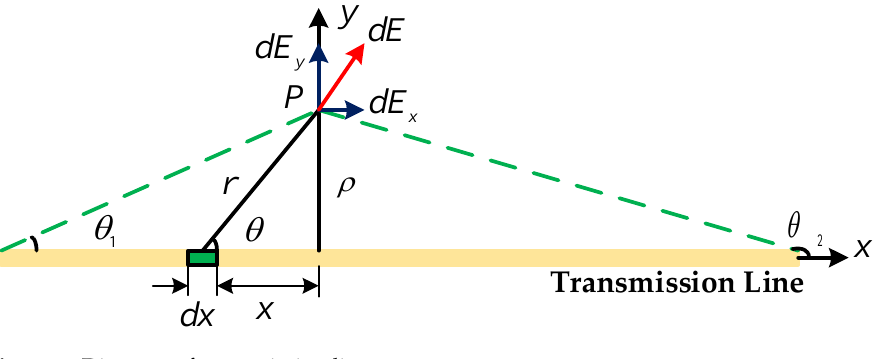
Figure 2. Diagram of transmission line.